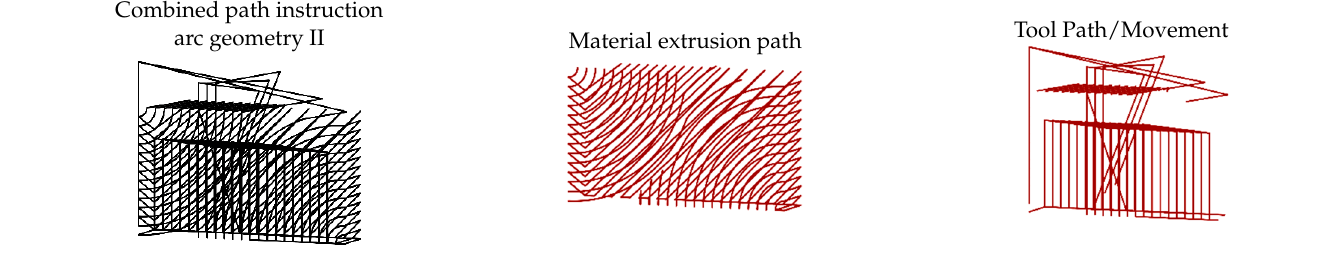
Tool Path/Movement